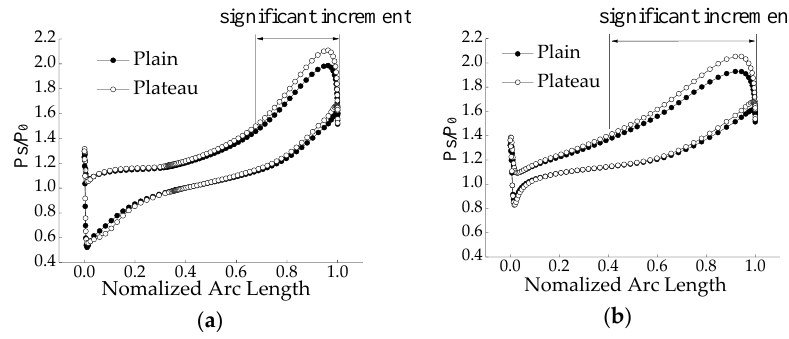
Figure 12. Load distribution of blade surface at 50% blade span: ( a ) main blade; ( b ) splitter blade.